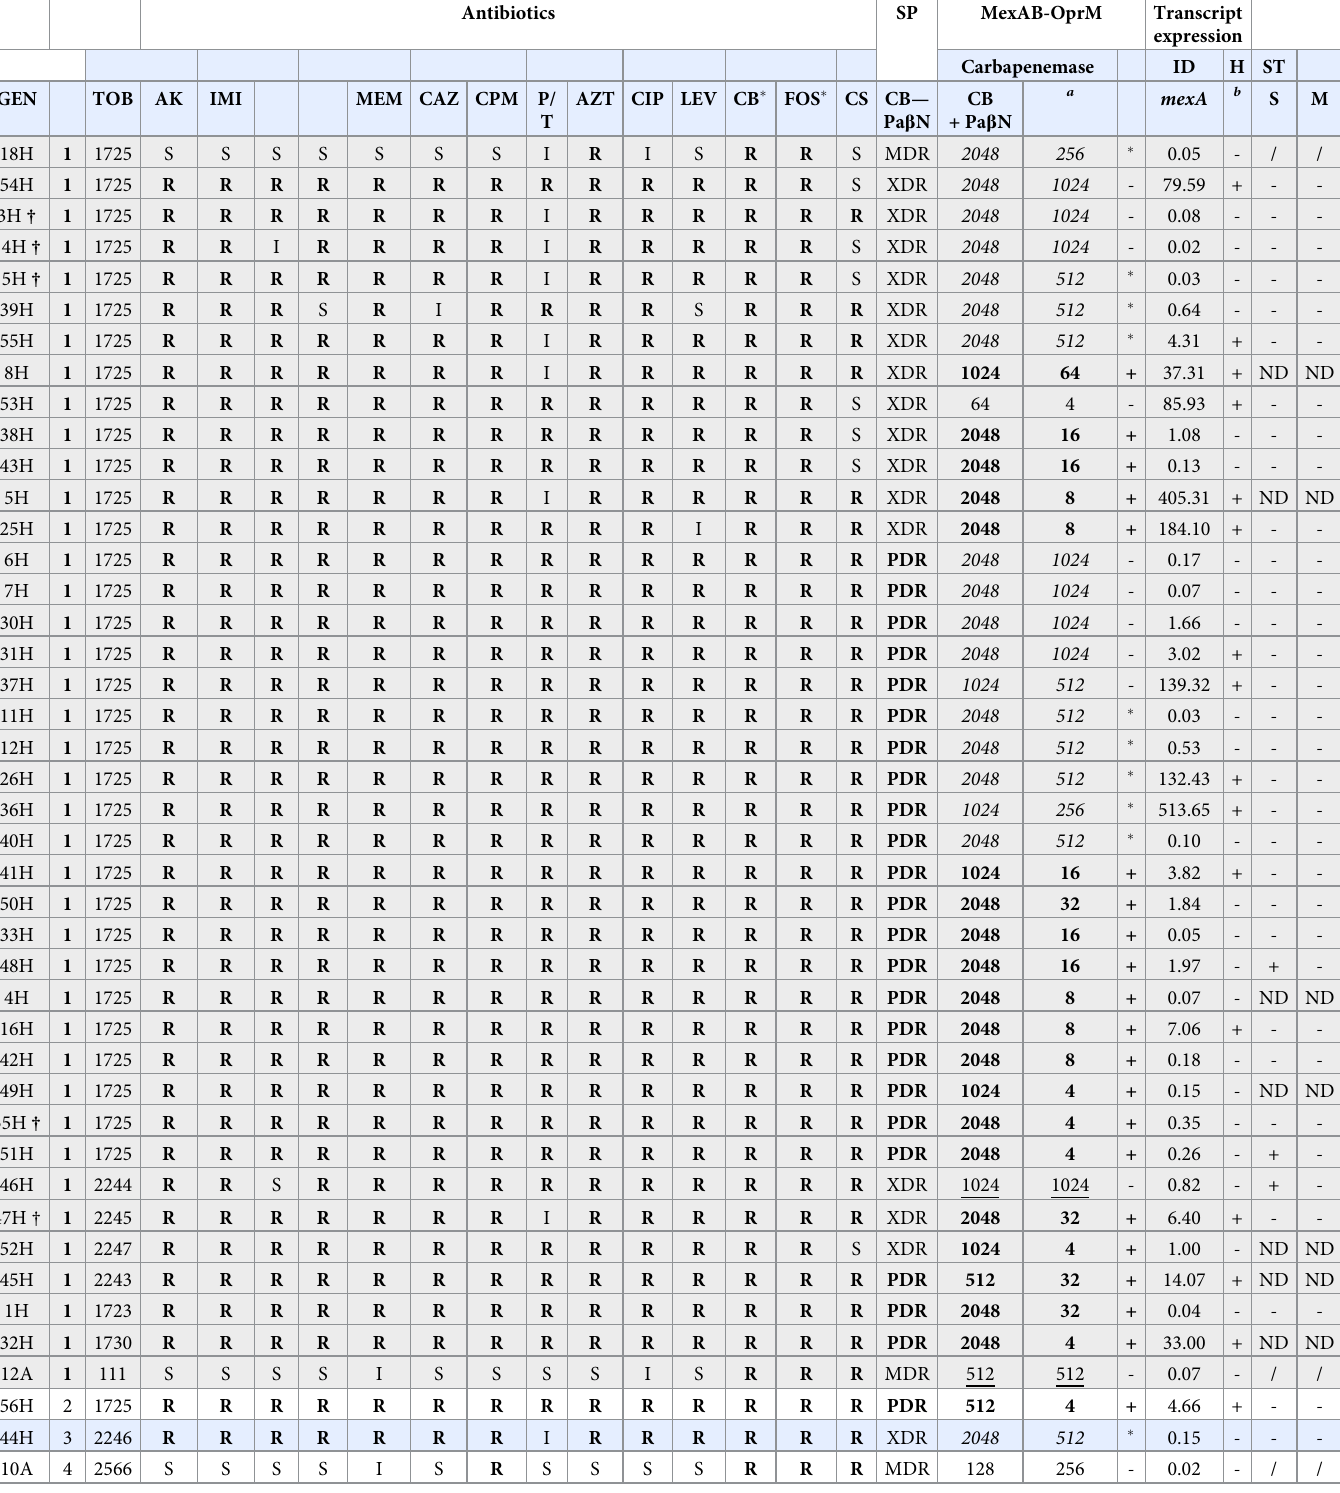
Table 1. Classification of the P . aeruginosa strains (origin, haplotype, susceptibility, MexAB-OprM phenotype, mexA transcript expression, and carbapenemase production).